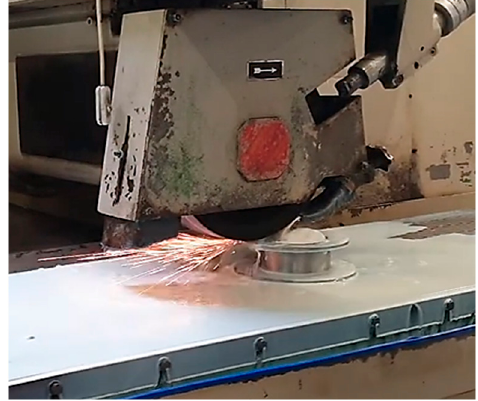
Figure 10. Grinding machine.